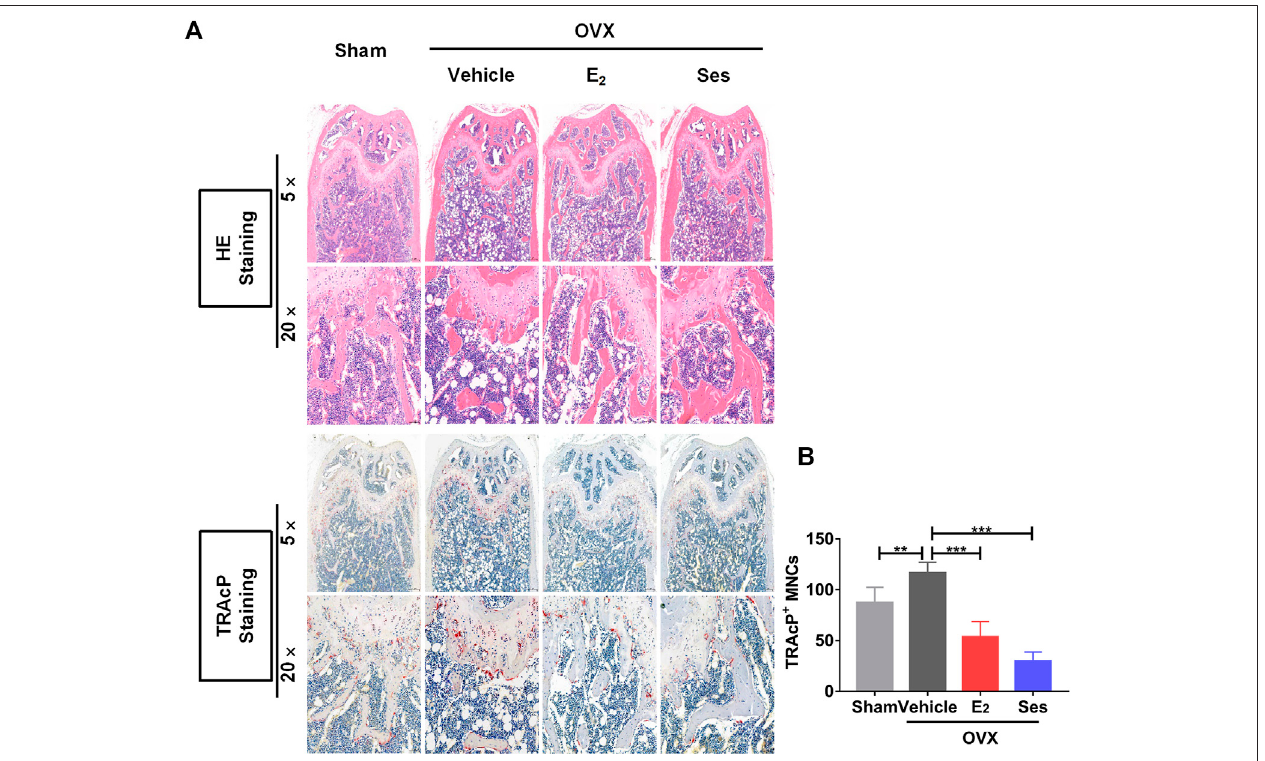
FIGURE10| Sestreatmentreducestheproductionofosteoclastsinovariectomizedmice. (A) Representativeimagesofhistologicalanalysisoffemursstainedwith HEandTRAcP. (B) QuantitativeanalysisofthenumberofTRAcP-positiveosteoclastsineachgroup( n (cid:1) 5).Theabovedataareexpressedasthemean ± SD;** p < 0.01, and *** p < 0.001. Ses, sesamolin; Vehicle, 1% DMSO in PBS; E 2 , estrogen; HE, hematoxylin and eosin; TRAcP, tartrate-resistant acid